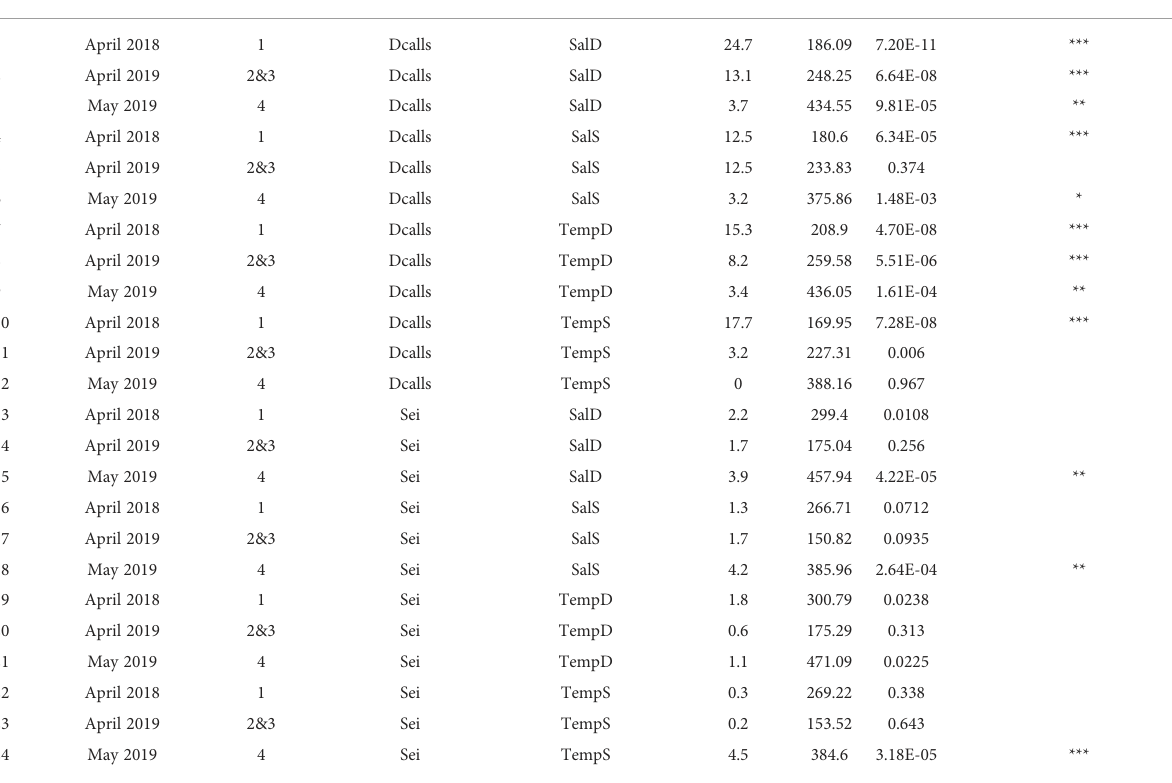
TABLE 3 Generalized Linear Models for percentage of day with presence of blue whale D-calls or sei whale calls (downsweeps and upsweeps) with temperature and salinity as explanatory variables, sorted by species and ranked by highest to lowest percentage deviance